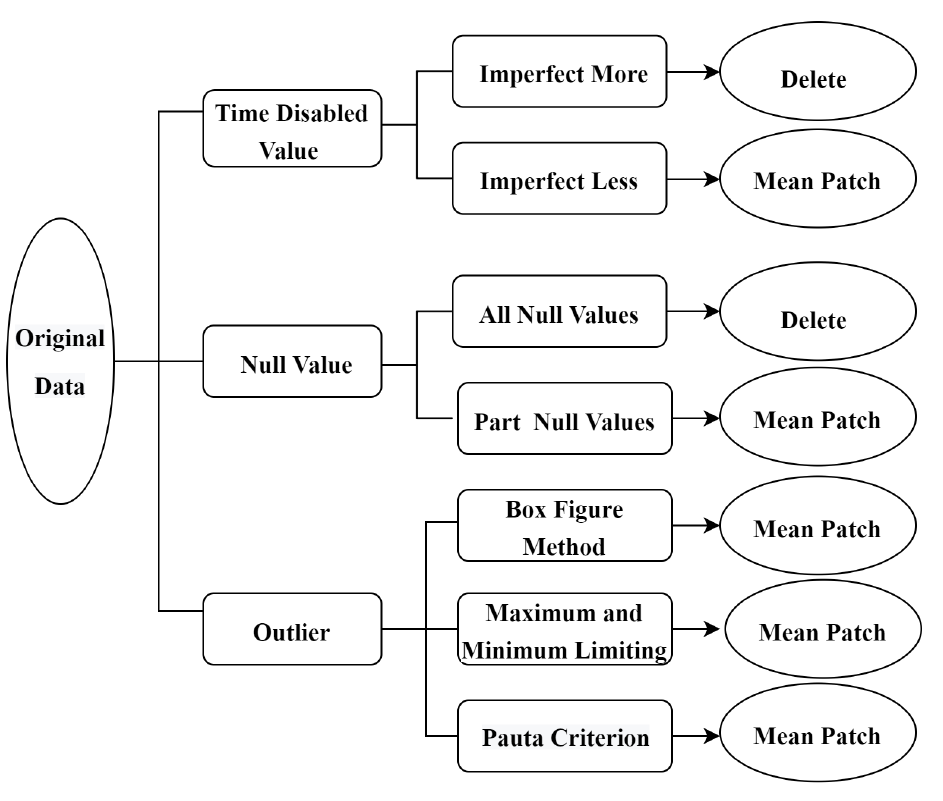
Figure 1. Data preprocessing